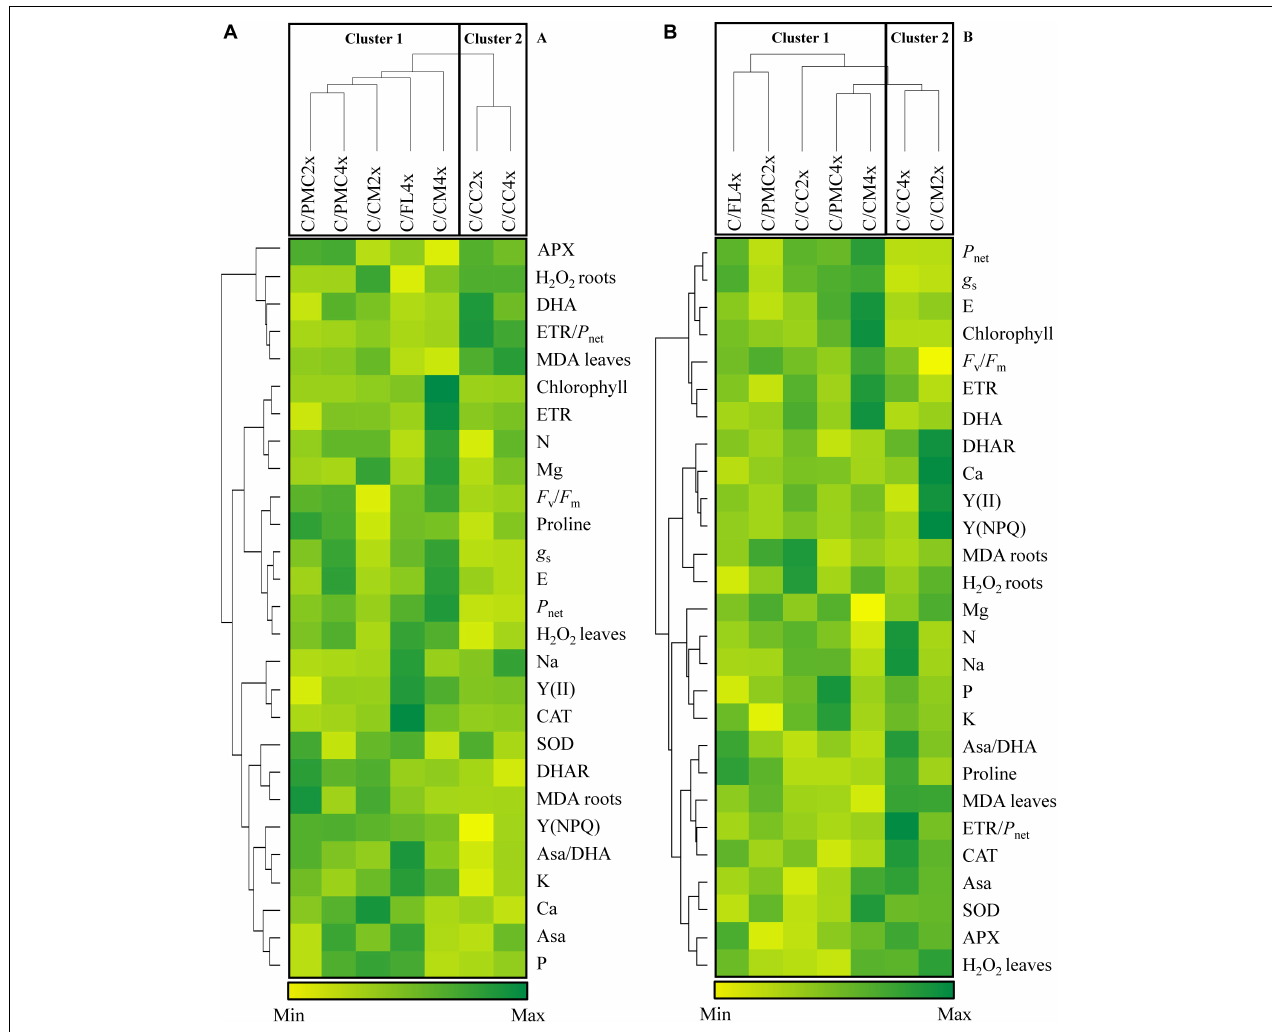
FIGURE 2 | Hierarchical cluster analysis and heatmap displaying mineral contents and parameters responding to nutrient deficiency in different scion/rootstock combinations after 210 days of nutrient deficiency (D210) (A) and after 30 days of recovery (30DR) (B) . Values are means of 3 independent ( n = 3) measurements for each parameter. Hierarchical cluster analysis dispatches the seven scion/rootstock combinations based on the different parameters. The heatmap shows the differences between the seven scion/rootstock combinations and treatments for each parameter. Color scale shows the intensity of the normalized mean values of different parameters. Values are associated with color ranging from yellow (low) to dark green